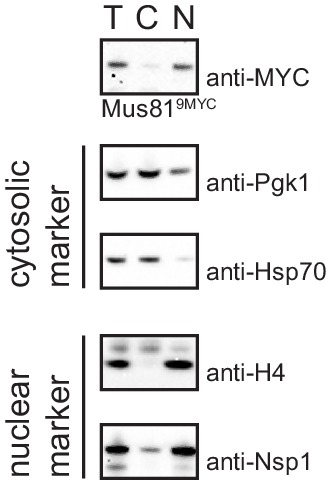
Nuclear/cytoplasmic fractionation.Western blot analysis of different fractions obtained after nuclei separation of a representable sample from the experiment in Figure 2B shows efficient separation into cytoplasmic and nuclear fractions. Pgk1 and chaperone Hsp70 serve as cytosolic markers, histone H4 and the nuclear pore complex protein NSP1 serve as nuclear markers. T = total lysate, C = cytoplasmic fraction, N = nuclear fraction.